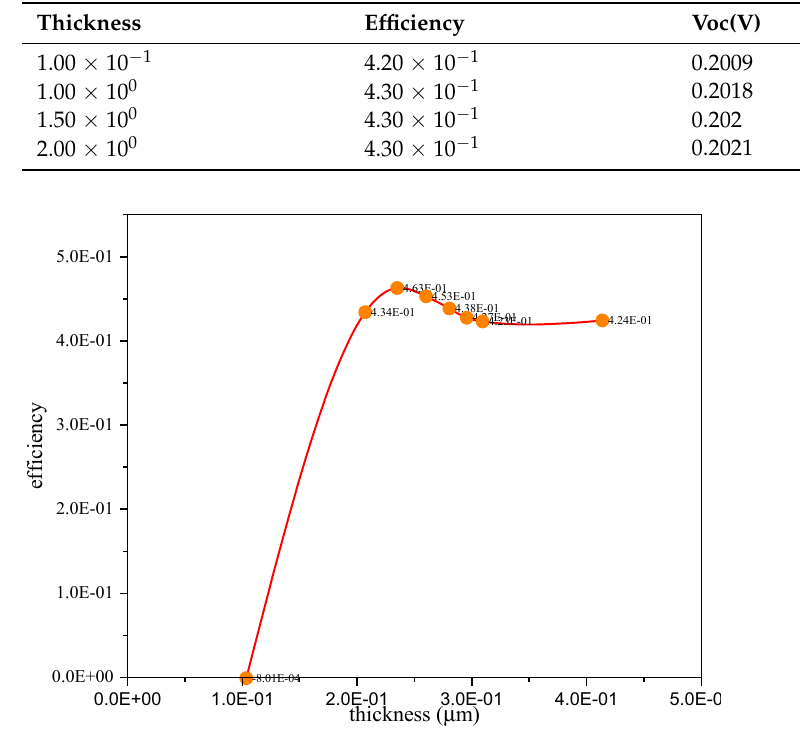
Figure 6. Schematic variation of efficiency with perovskite thickness.